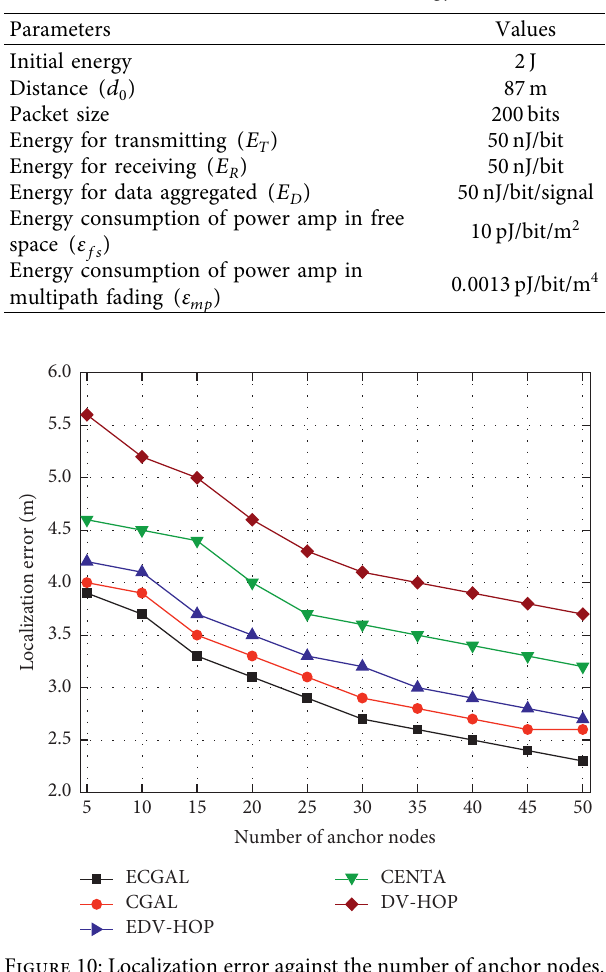
Table 2: Parameters used in the energy model.